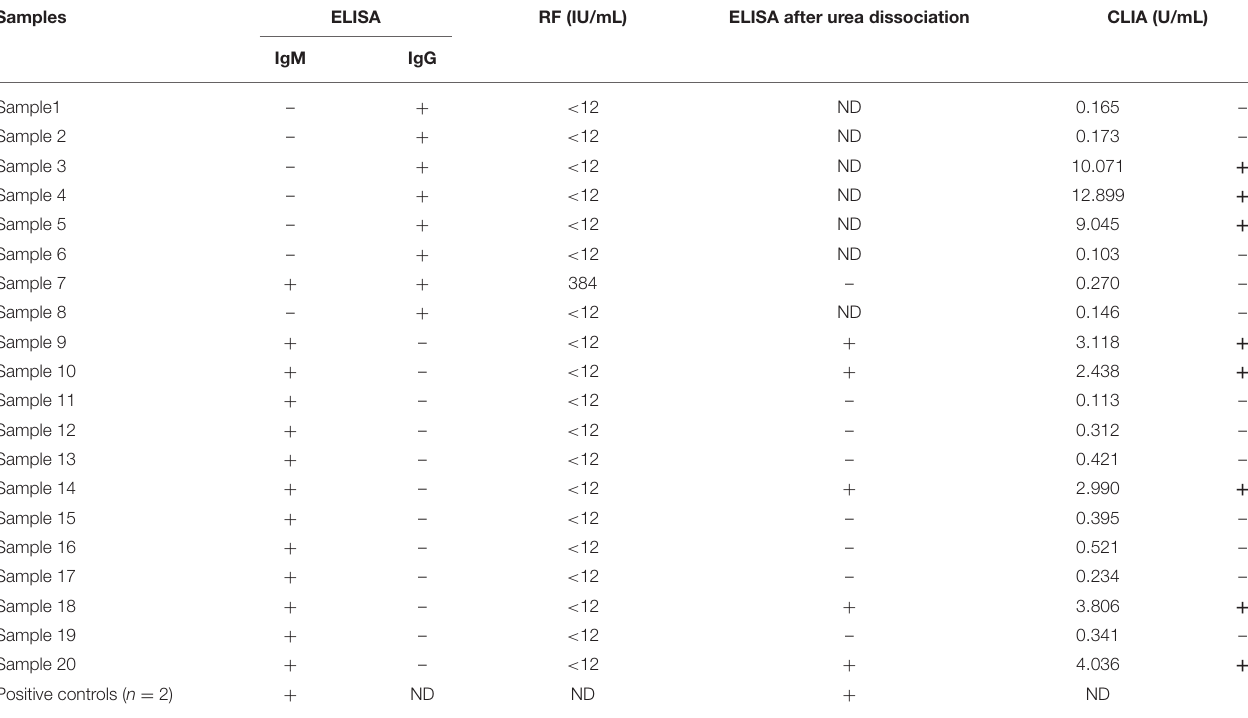
TABLE 2 | Serological assays for detection and confirmation of SARS-CoV-2 antibodies in the study samples. Samples ELISA RF (IU/mL) ELISA after urea dissociation CLIA